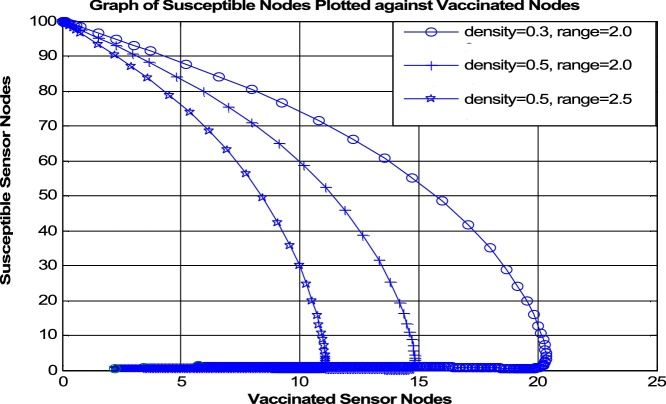
Susceptible vs Vaccinated w.r.t. to σ and ro2 [13].